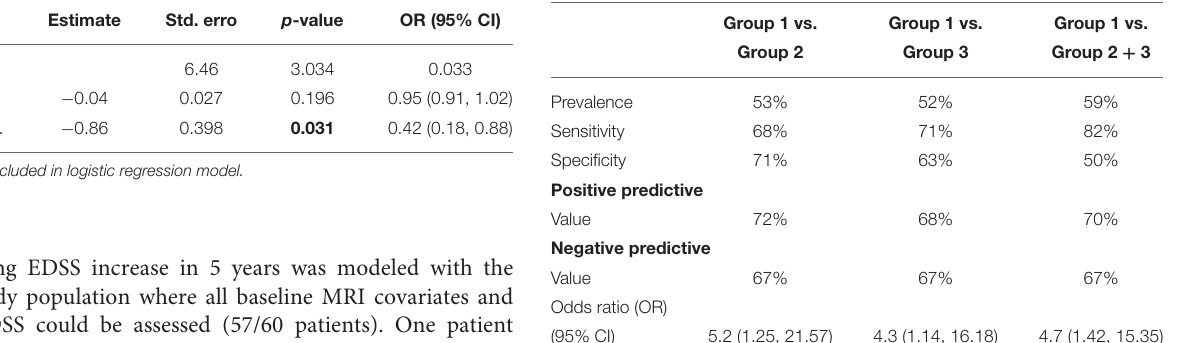
TABLE 3 | The predictive value of baseline brain atrophy measures to EDSS change at 5 years. Group 1